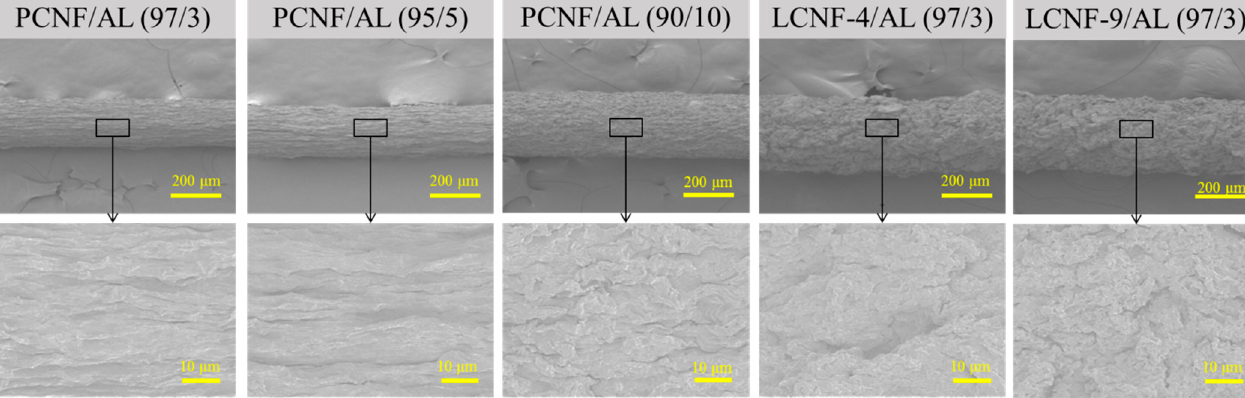
Figure 4. Morphological characteristics of wet-spun composite filament from PCNF/AL, LCNF-4/AL, and LCNF-9/AL with different ratios of CNF/AL at spinning rate of 10 mL/min.